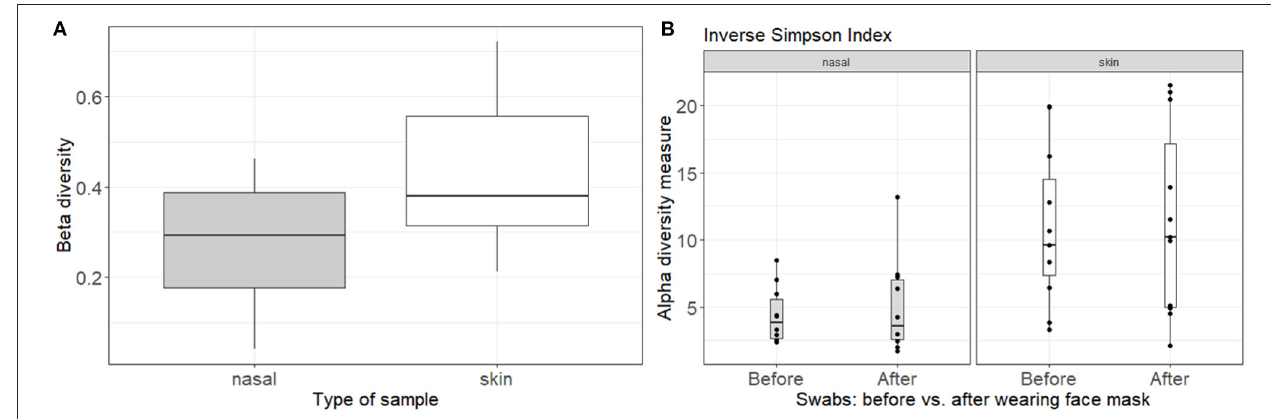
FIGURE 4 | Analysis of the bacterial composition of the nasal and skin microbiome before and after wearing a face mask for 4h. (A) Beta-diversity by Bray-Curtis dissimilarities, comparing the beta-diversity of the skin and nasal microbiome before and after wearing a face mask for 4h. (B) Alpha-diversity by Inverse Simpson Index, grouped by time point (before and after wearing a face mask) and plots split for nasal and skin microbial samples.